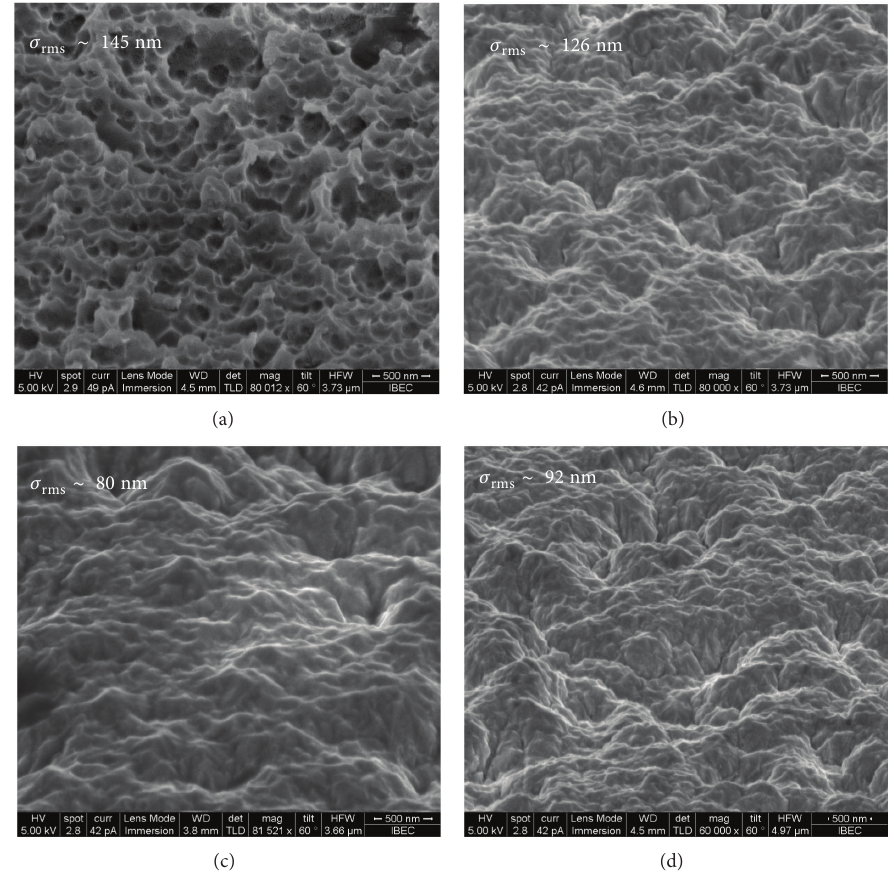
Figure 5: HRSEM (tilted at 60 ∘ ) micrographs of (a) texture S, (b) S + AZO1 (500 nm), (c) S + AZO2 (700 nm), and (d) S + AZO3 (1000nm). values were obtained from AFM. The 𝜎 rms